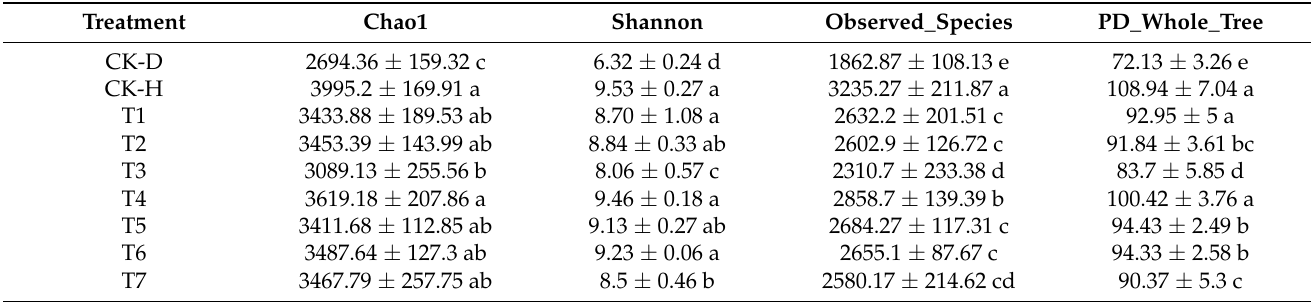
Figure 2. Plant-growth promotion potential of candidate biocontrol strains as single strains, intra/inter-genus co-culture, and microbial consortia on Chinese cabbage. Significant differences between treatments are shown by different small letters on the error bars according to Duncan’s multiple-range test at p < 0.05. Disease control (CK-D), healthy control (CK-H), single-strain Lysobacter antibioticus 13-6 (T1), single-strain L. capsici ZST1-2 (T2), single-strain Bacillus cereus BT-23 (T3), intra-genus co-culture of L. antibioticus 13-6 + L. capsici ZST1-2 (T4), inter-genus co-culture of L. antibioticus 13-6 + B. cereus BT-23 (T5), microbial consortia B. cereus BT-23 + L. antibioticus 13-6 + L. capsici ZST1-2 (T6), and commercial fungicide Kejia (T7). Table 1. Effect of single strains, intra/inter-genus co-culture, and microbial consortia on alpha diversity of bacterial communities associated with the rhizosphere of Chinese cabbage ( ± SEM, n =